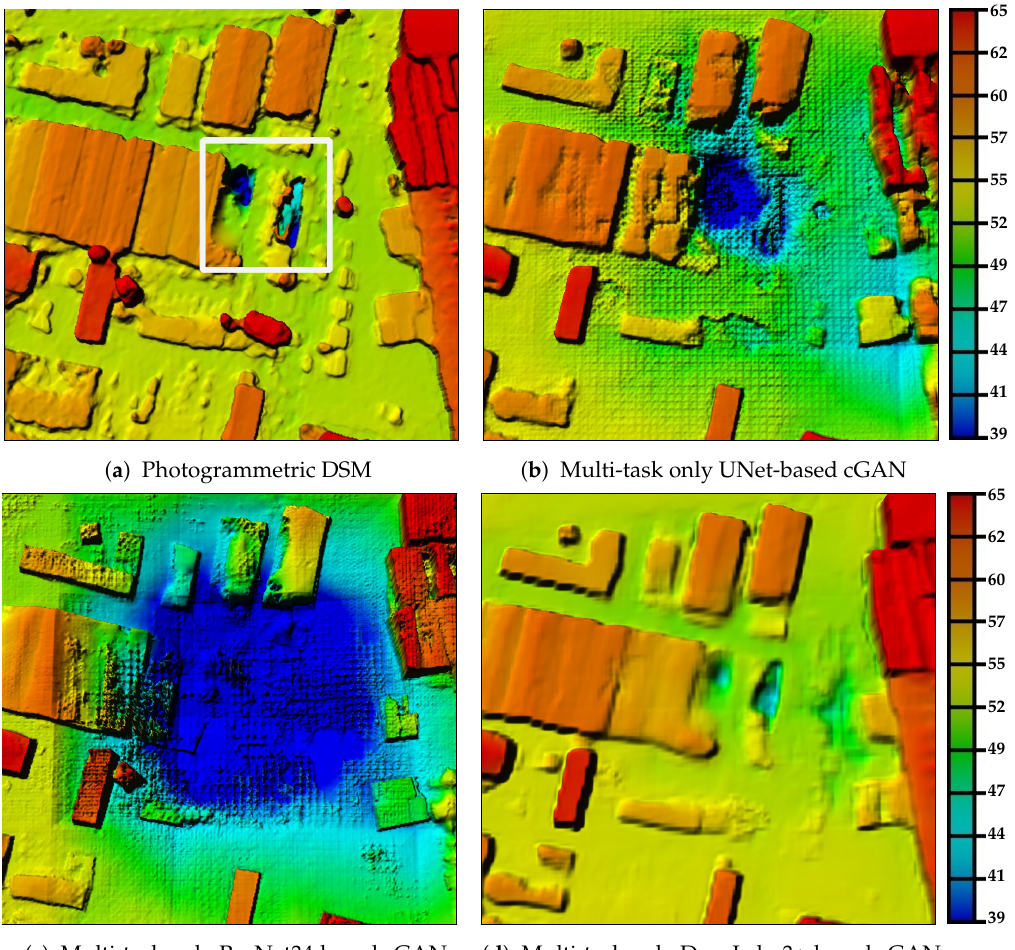
Figure 5. A detailed demonstration of a failure case example on generated LoD2-like DSMs obtained by the UNet-, ResNet34-, and DeepLabv3+-based network Figure 2a architectures. ( a ) depicts the input photogrammetric DSM with the area highlighting the presented incorrect height information and its influence on the reconstructed LoD2-like DSMs from ( b ) multi-task only UNet-based cGAN, ( c ) multi-task only ResNet-based cGAN, and ( d ) multi-task only DeepLabv3+-based cGAN. The area that undergoes the influence is presented as a darker blue shade around the location where the failure is originated in ( a